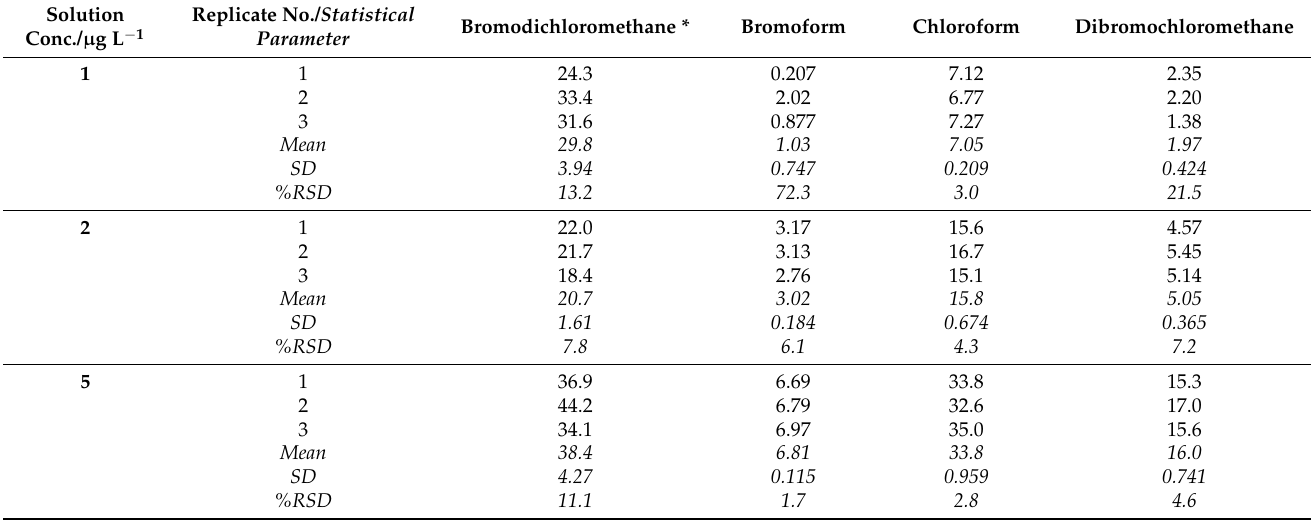
Table 5. Determination of the method LOQ for the THMs using solution concentrations of 1, 2, and 5 µ g L − 1 . Headspace concentrations (in ppbV) are averaged across both/all quantitation ions used to target the compound. The RSD is reported as a